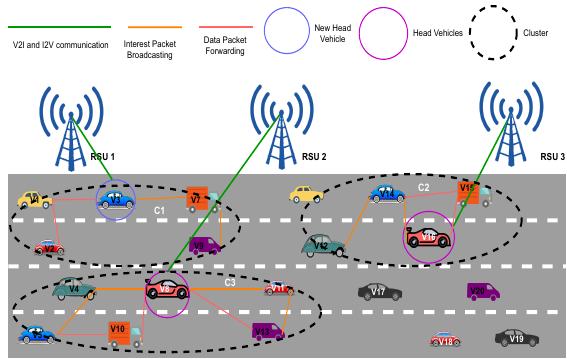
Figure 6. New Head Vehicle Selection in Proposed